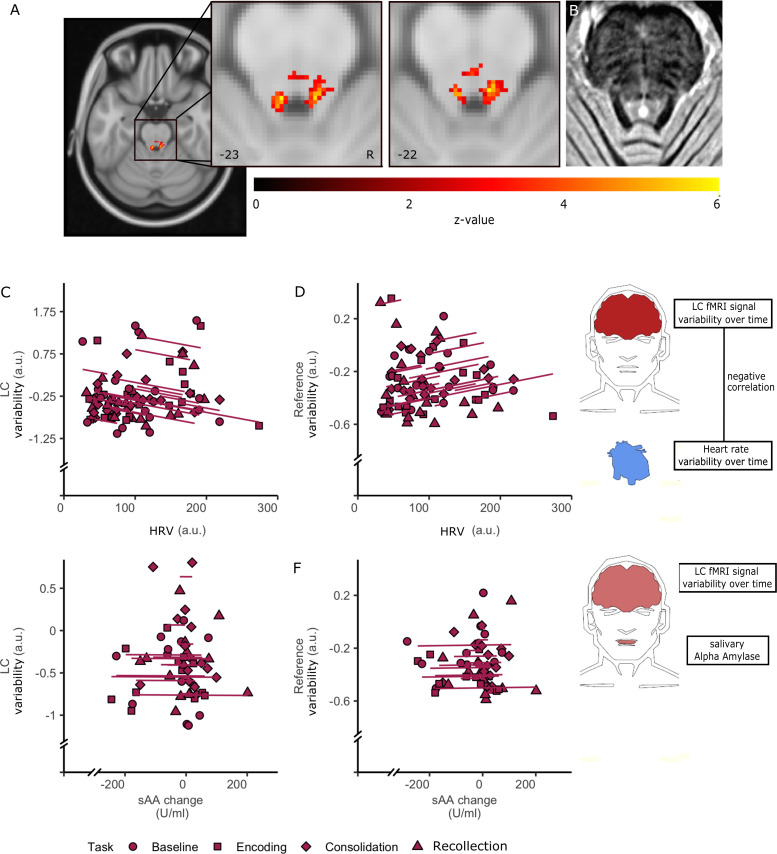
Associations between LC BOLD and autonomic tone measures using repeated measures correlations.(A–B) LC component visualization. (A) Group average t-map from the dual-regression showing a robust bilateral LC component, thresholded at p<0.01 FWE, after denoising with FIX (N = 24). (B) LC template from all scans. A hyperintensity can be observed close to the 4th ventricle. (C–F) Repeated correlations between LC variability rMSSD (p=0.008, N = 23, 92 observations) or ΔsAA (not significant, p=0.971, N = 17, 56 observations) (C,E). Similar associations are shown for variability in the reference component (D,F) (no significant relationships, p=0.109 and p=0.942, respectively, N = 17, 56 observations). Each marker signifies a participant and distinct shapes show the different task stages.Figure 4—source data 1.Locus coeruleus BOLD and autonomic tone measures across the entire paradigm.Individual ΔsAA, rMSSD, LC and reference BOLD values per task stage. Individual coherence values between.